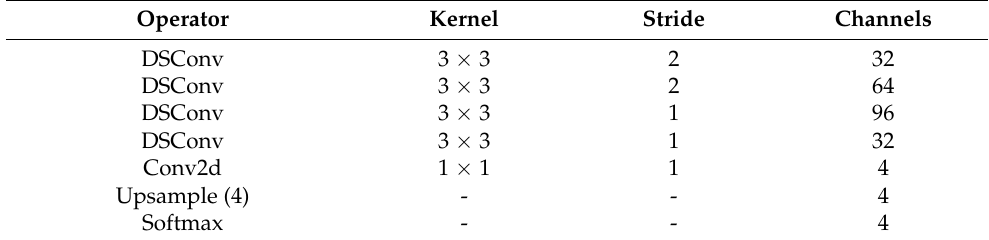
Figure 8. Result of stage 1. Hard Pixels image shows the pixels that stage 1 detected as difficult